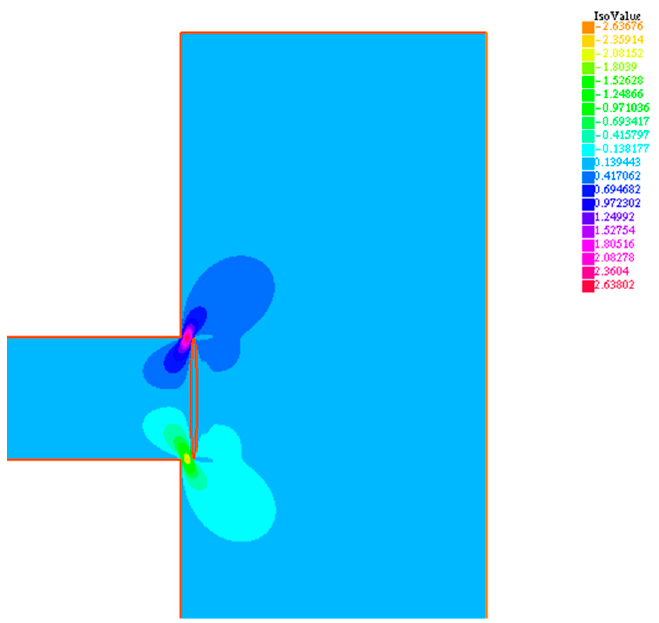
Figure 6. Case 1: valve operative condition with h = 3 mm, with velocity vertical component v . Machines 2018 , 6 , x FOR PEER REVIEW